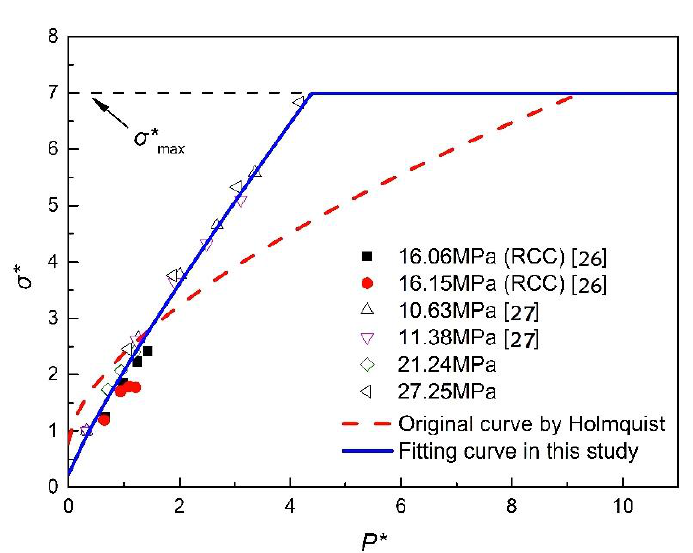
Figure 5. Determinations of the yield surface by triaxial compression data.